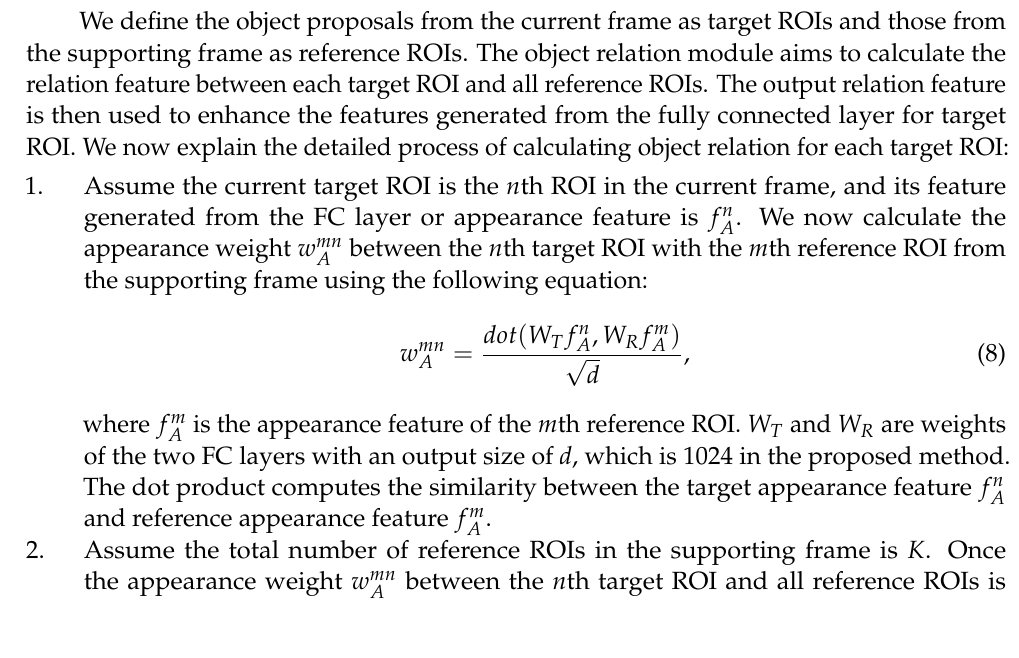
Figure 6. Architecture of the object relation module. First, the adaptive ROI pooling is utilized to pool features based on the object proposal’s aspect ratio. Each pooling size corresponds to a fully connected layer with a size of 1024. Then, the object relation module produces the relation feature between each target ROI and all reference ROIs to enhance the feature map generated by the FC layers for target